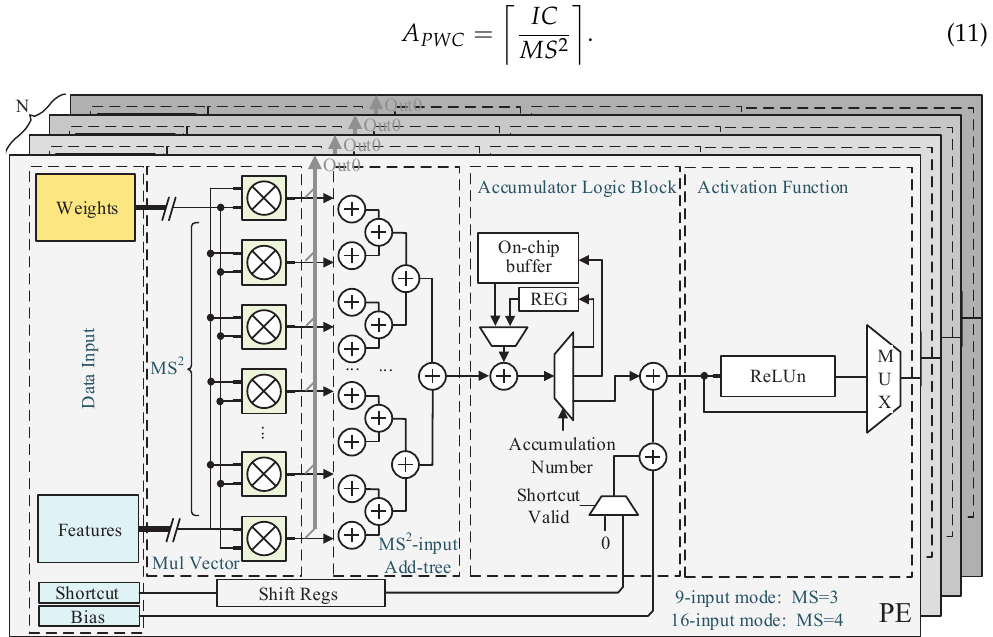
Figure 3. Block diagram of multiplication and accumulation